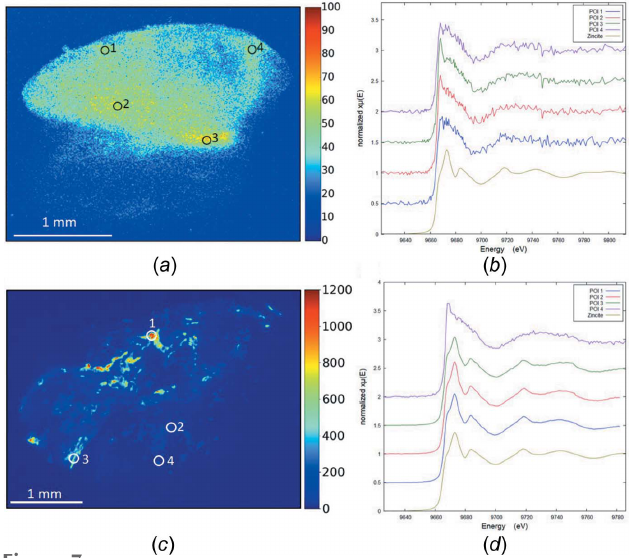
Figure 7 XRF maps with localized POI and XANES spectra at the Zn K -edge (patients 2 and 8). A reference spectrum of zincite (ZnO) is also shown as comparison. ( a , b ) Patient 2, the four spectra are similar and consistent with endogenous Zn. ( c , d ) Patient 8, three spectra are consistent with exogenous Zn (ZnO), and one with endogenous Zn (POI